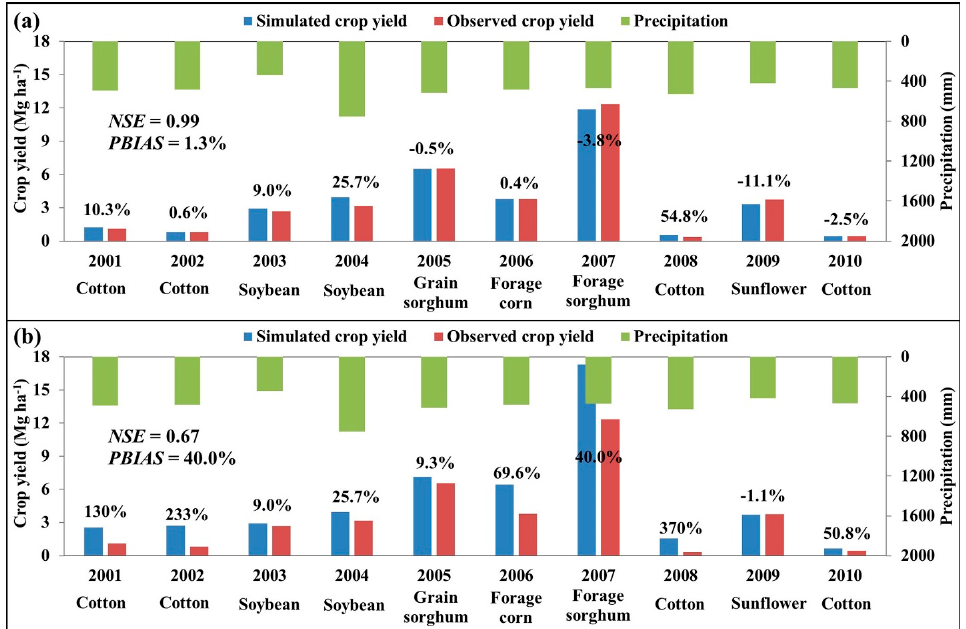
Figure 4. Comparison of observed and simulated crop yield under the baseline scenario ( a ) and under the auto-irrigation scenario of 36 mm soil water deficit trigger ( b ).